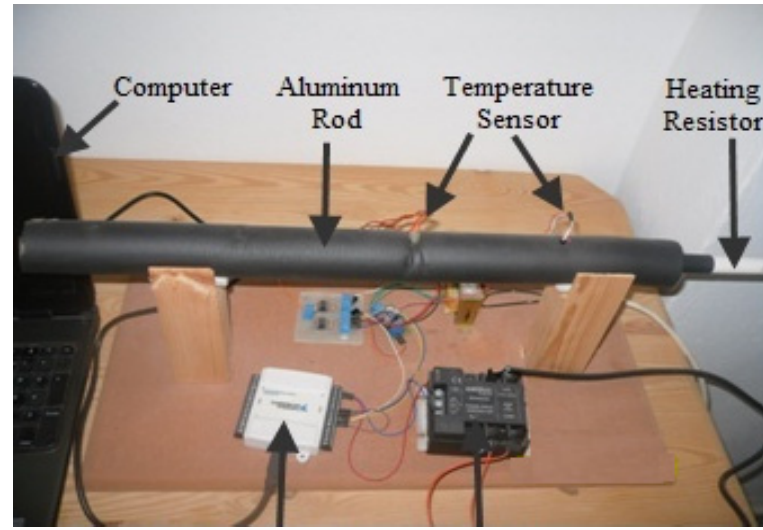
Figure 1. Fractional thermal process.